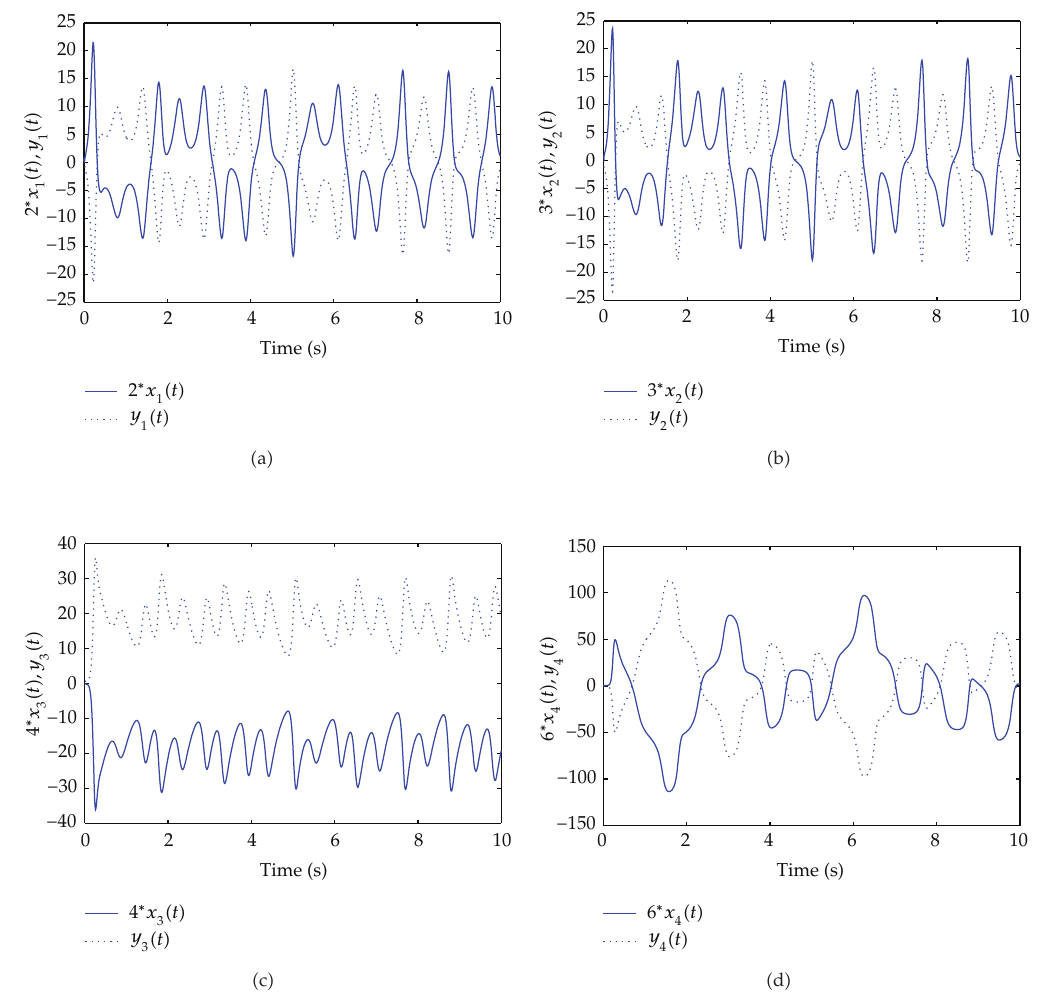
Figure 5: The state synchronization trajectories of the master system (cid:6) 3.1 (cid:7) and slave system (cid:6) 3.2 (cid:7) under control law (cid:6) 3.15 (cid:7)